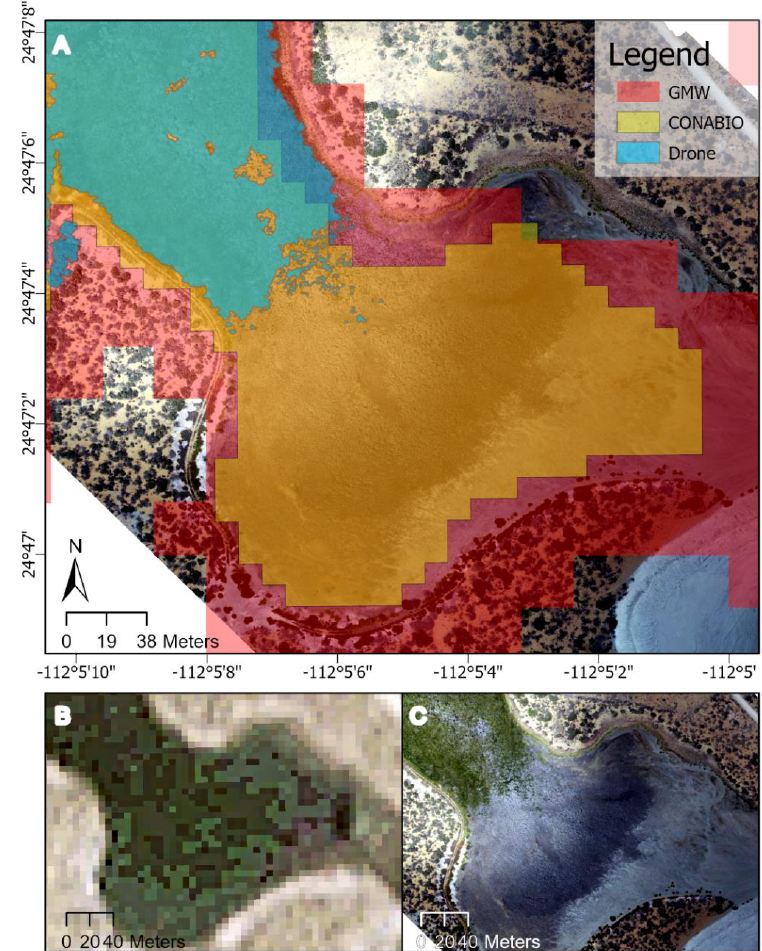
Figure 7. In Puerto San Carlos, ( A ) mangroves identified by CONABIO (yellow), GMW (red), and drones (blue), overlaid on top of drone imagery taken in 2018; ( B ) 5 m imagery from RapidEye taken in February 2015, which CONABIO may have had access to when developing their 2015 inventory; and ( C ) drone imagery taken May 2018, with a resolution of 0.03 m. Dredged sediment can be seen in the lower southeastern corner of (A) and (C).